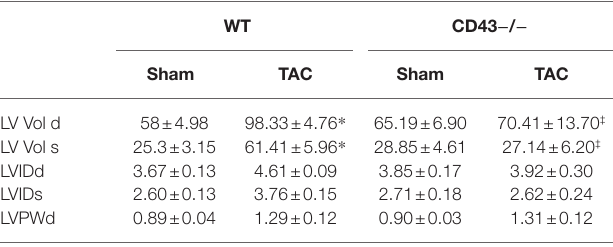
LVIDd, left ventricular internal diameter end diastole; LVIDs, left ventricular internal diameter end systole; and LVPWd, left ventricular posterior wall thickness end diastole. Values are means ±